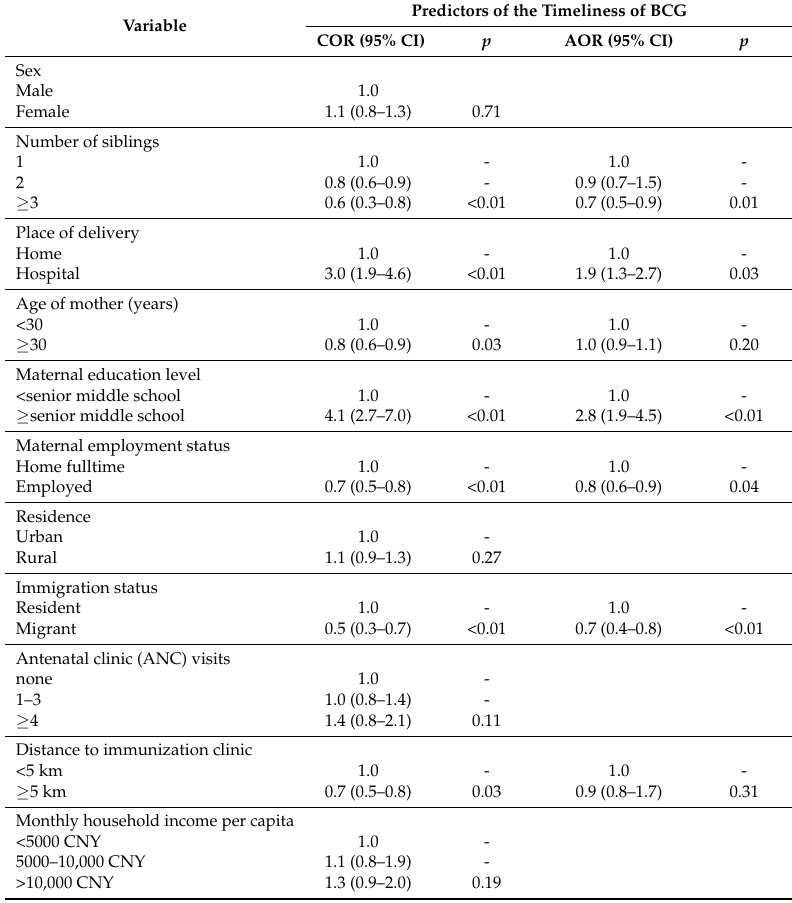
Table 4. Univariate and multivariate analyses of the predictors associated with the timeliness of BCG vaccination